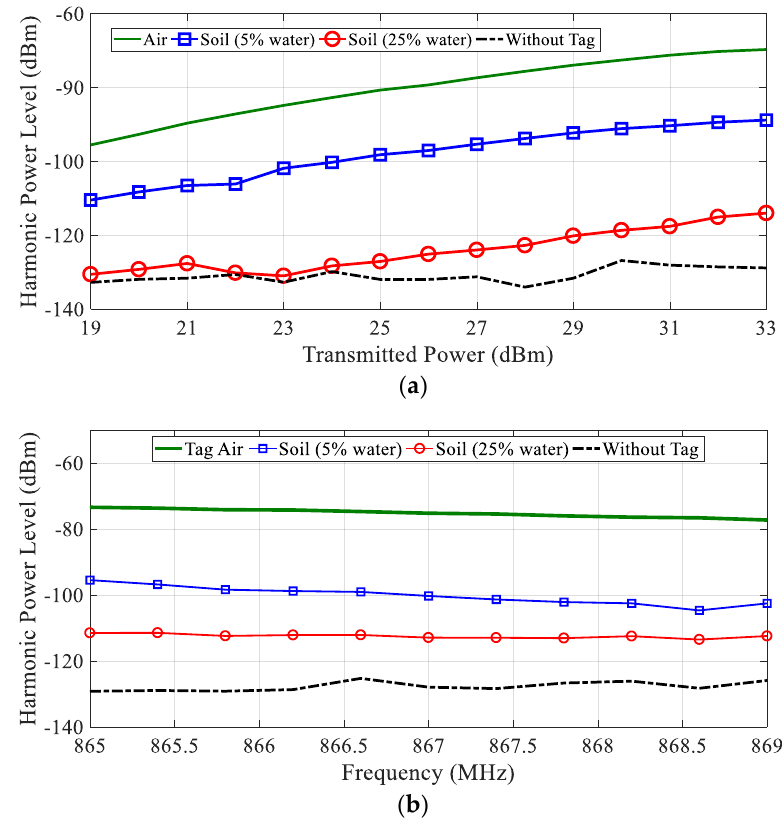
Figure 14. ( a ) Measured tag response under different conditions (tag in the air, buried in the soil, and without tag) as a function of the transmitted power (equivalent isotropic radiated power — EIRP) and a function of the input frequency ( b ) for the EIRP of 33 dBm.